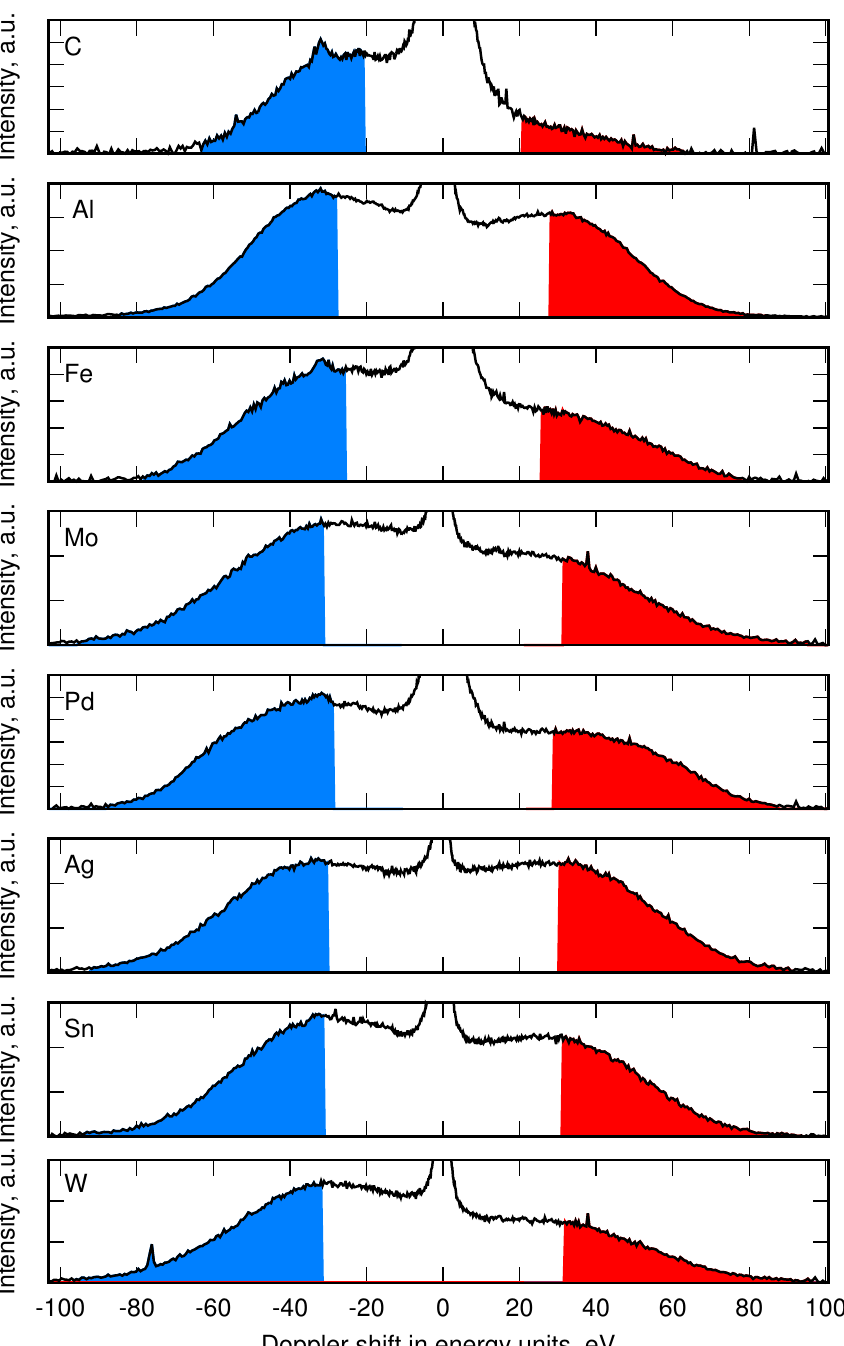
Figure 8. Emission of reflected atoms at the Balmer- α line in front of C, Al, Fe, Mo, Pd, Ag, Sn, and W. The applied potential is − 100 V for all targets. The spectra measured in front of C, Al, Fe, Ag, Sn, and W are taken from